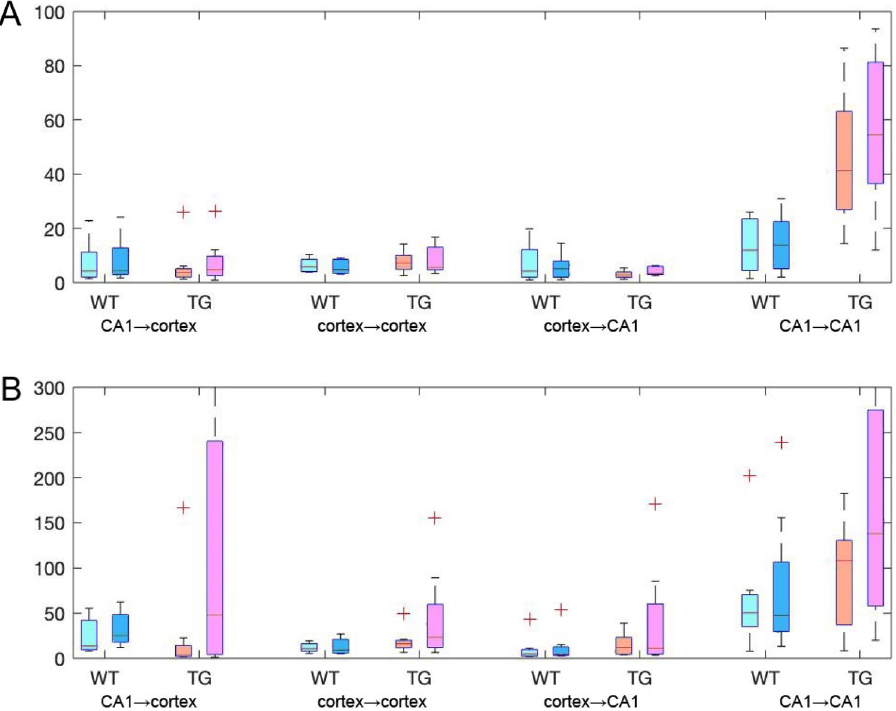
Figure 8. The total strength of interactions expressed between brain structures during episodes not containing SWRs ( A ) and coincident with SWRs ( B ). Shown are (from the left to the right): coupling from CA1 to cortex, between cortices, from cortices to CA1, and between two CA1. On each box, the central mark indicates the median, and the bottom and top edges of the box indicate the 25th and 75th percentiles, respectively. The whiskers extend to the most extreme data points not considered outliers, and the outliers are plotted individually using the ’ + ’ symbol. Boxes relating to WT mice—before learning light blue, after learning dark blue; boxes relating to TG mice—before learning orange, after learning magenta. Please note the different vertical scales of the upper and lower picture.